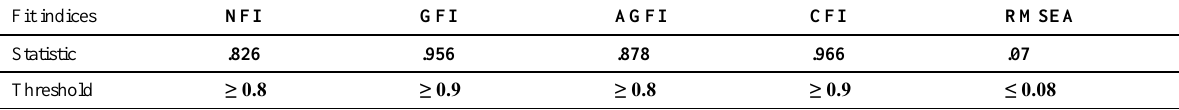
Table 9: Model fit indices- Technological Innovation, Service Quality and performance